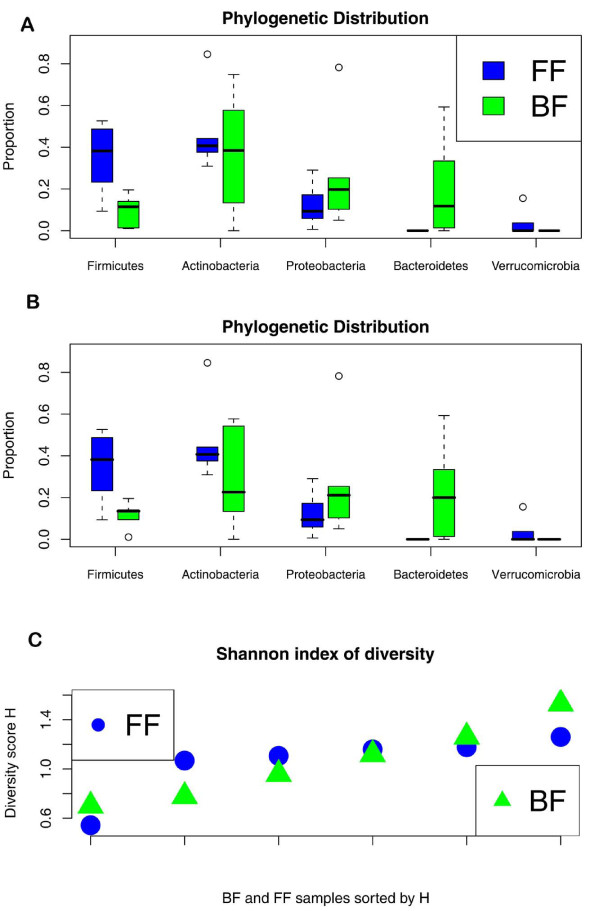
Effect of diet on infant microbiota. BF (breast-fed) infants (green) exhibited more heterogeneity than FF (formula-fed) infants (blue) with respect to phylogenetic composition. (a) Taxon assignment (phylum level) variability for BF and FF samples using 16S rRNA alignments to GreenGenes (see Materials and methods). A diet label permutation test using the statistic ∑s |∑iεBF pis/6 - ∑iεFF pis/6|, where s indexes phylum and iεBF and iεFF denote that sample i is BF or FF infant, respectively, and p denotes the associated taxon proportion, rejected the null hypothesis that variability in phylogenetic composition was unrelated to BF/FF status with a P-value of 0.011. (b) Taxon assignments for all the shotgun reads (not just 16S rRNA homologs) using PhymmBL [17]. (c) Shannon-Weiner index for BF and FF infants, indicating alpha-diversity for each sample.